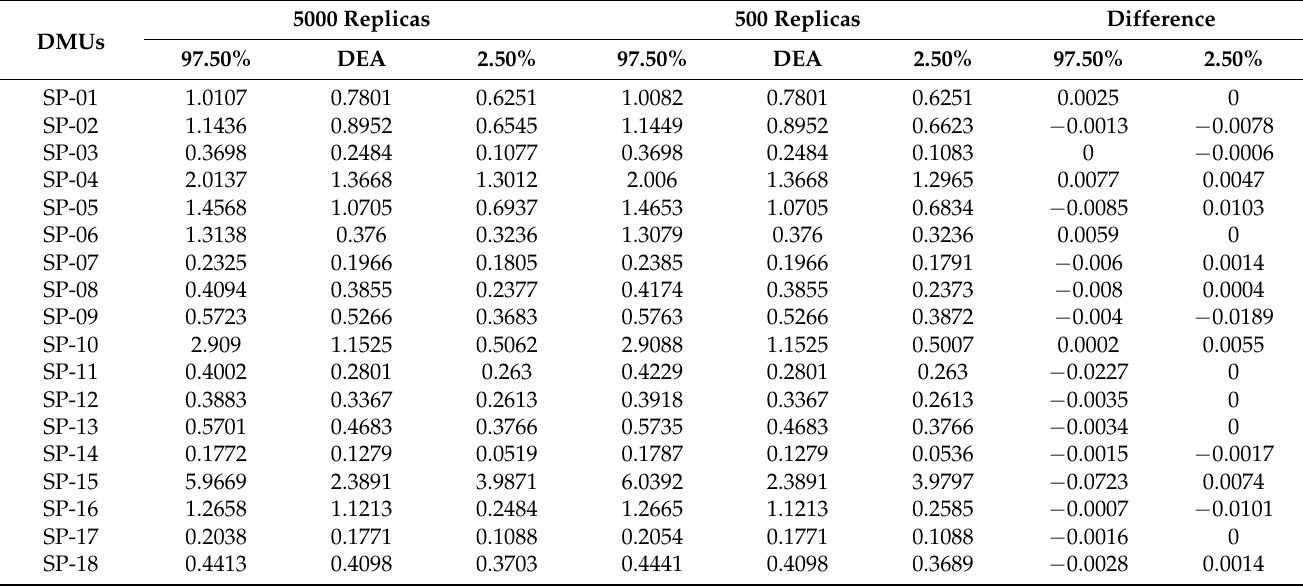
Table 4. Comparisons of 5000 and 500 replicas